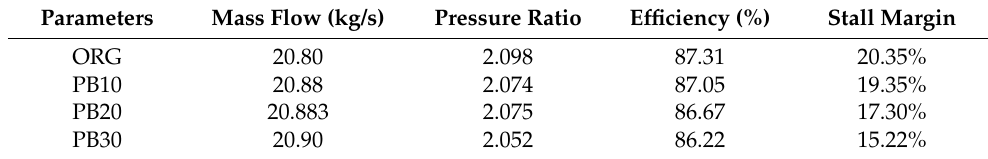
Table 4. Comparison of design point performance and stall margin of PB10, PB20, and